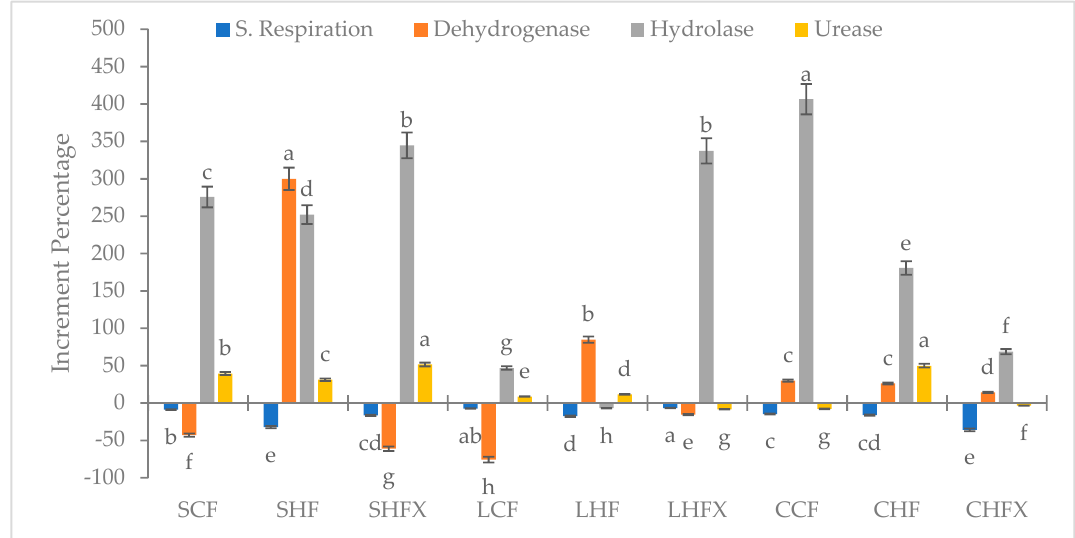
Figure 1. Increment (30 min to 24 h) of soil respiration, dehydrogenase activity, hydrolase activity and urease activity in the soils: sandy loam (S), clay loam (L) and clay (C) soils using the nutrient solutions: conventional fertilization (CF), MCT ® fertilizers (HF) and MCT ® fertilizers plus TX (HFX). Different letters indicate significant differences between treatments ( n = 3; Duncan’s test, p <